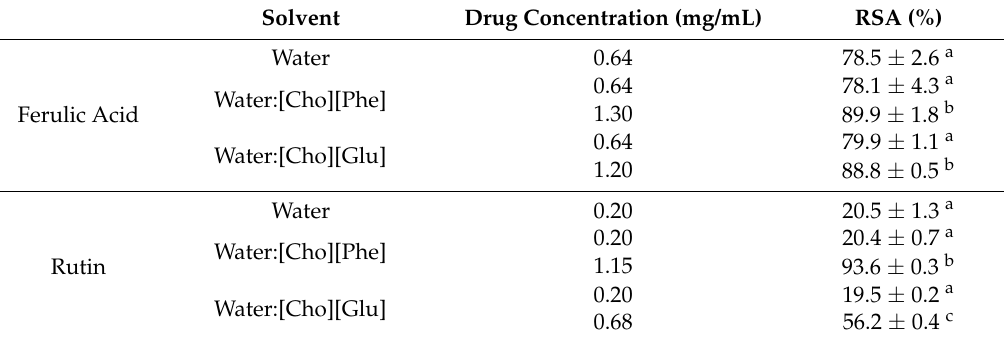
Table 2. Radical scavenging activity (RSA) of ferulic acid and rutin, in water and in water:IL (99.8:0.2% v/v ) mixtures, expressed as the percentage inhibition of the DPPH